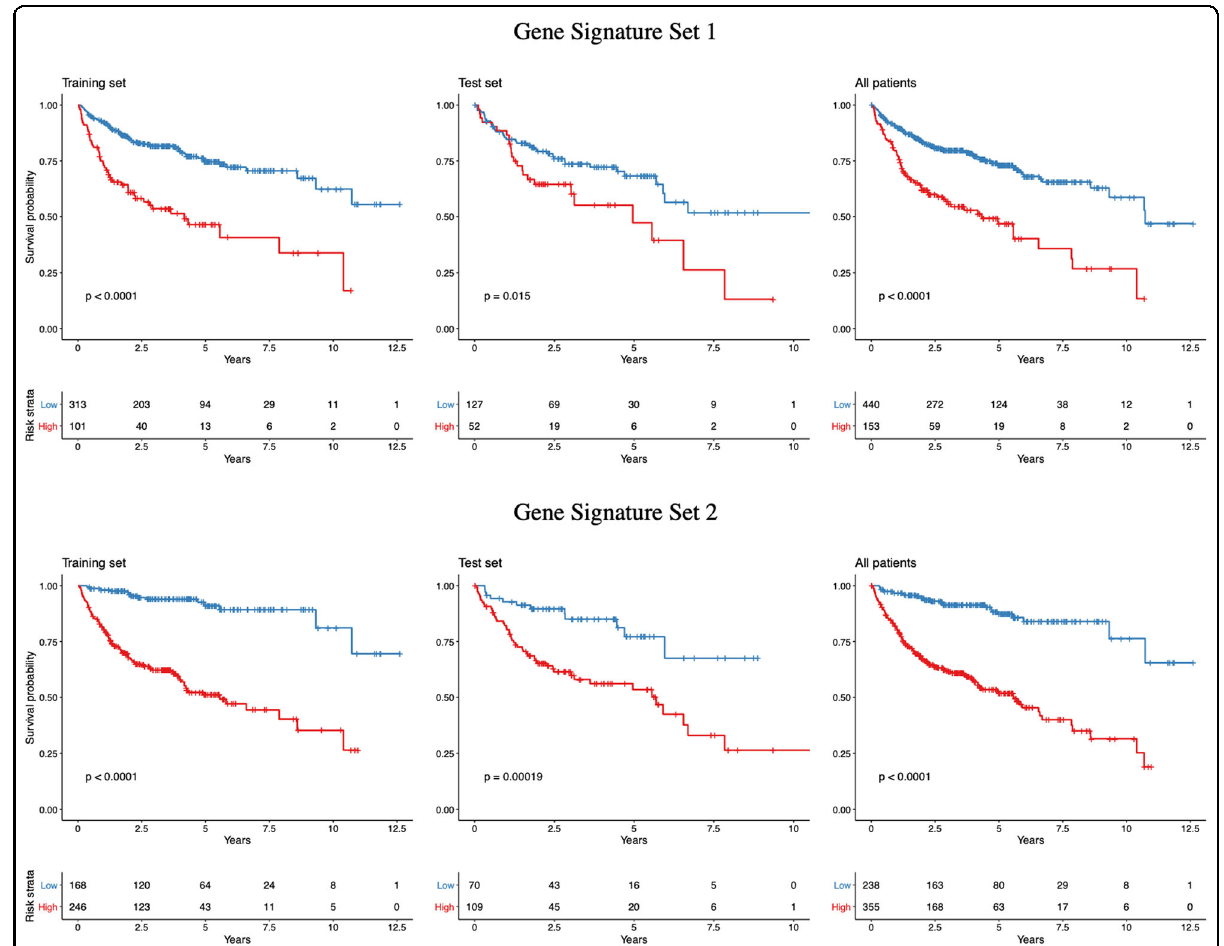
Fig. 3 Overall Survival Analysis of Gene Signature Sets 1 and 2. The overall survival among the patients in the training, test, and entire sets according to the optimal cut-offs for the gene expression-based survival-predictor scores obtained from the models with signature sets 1 and